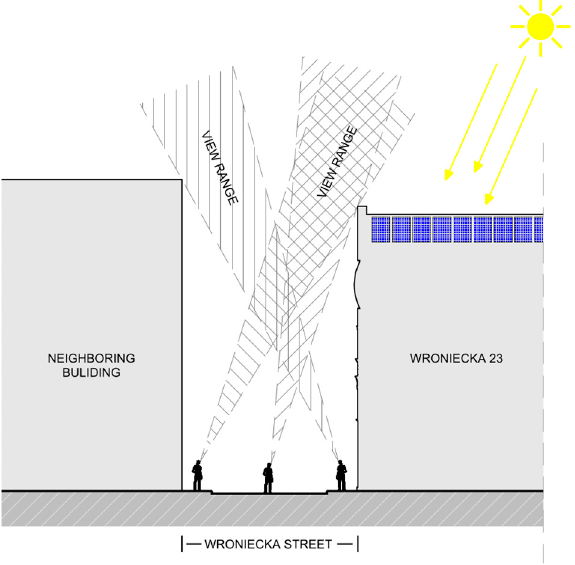
Figure 17. View ranges from the public space at Wroniecka Street—Diagram.